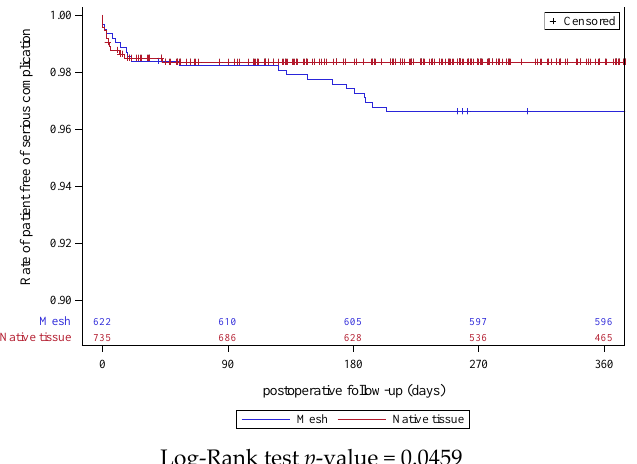
Figure 2. Kaplan – Meier curve for Clavien – Dindo grade IIIa or higher complications comparing Figure 2. Kaplan–Meier curve for Clavien–Dindo grade IIIa or higher complications comparing SSLF SSLF with mesh or with the native tissue. with mesh or with the native tissue.